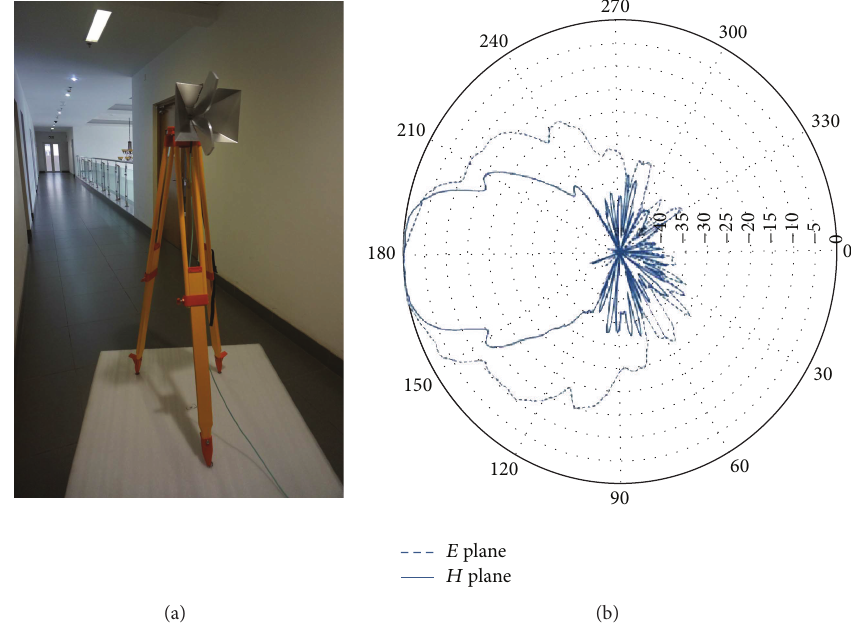
Figure 3: (a) Directional antenna: OBH08180. (b) Antenna pattern of OBH08180.